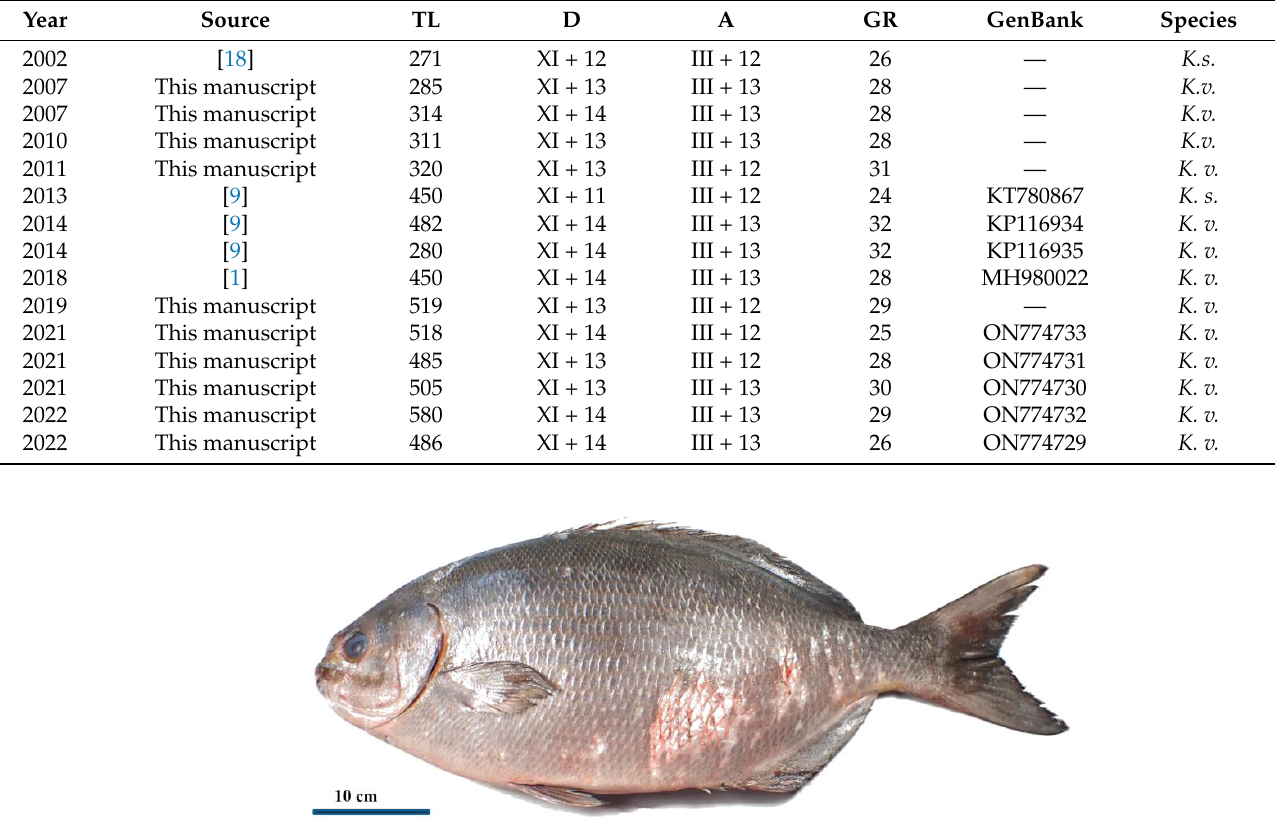
Table 1. Historical records of Kyphosus specimens in Galician waters (NW Spain) with its morpholog-